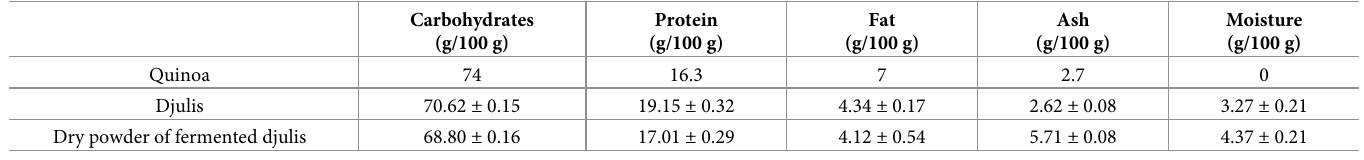
Table 5. Carbohydrates, protein, fat, ash and moisture of Chenopodium formosanum Koidz. fermented product.